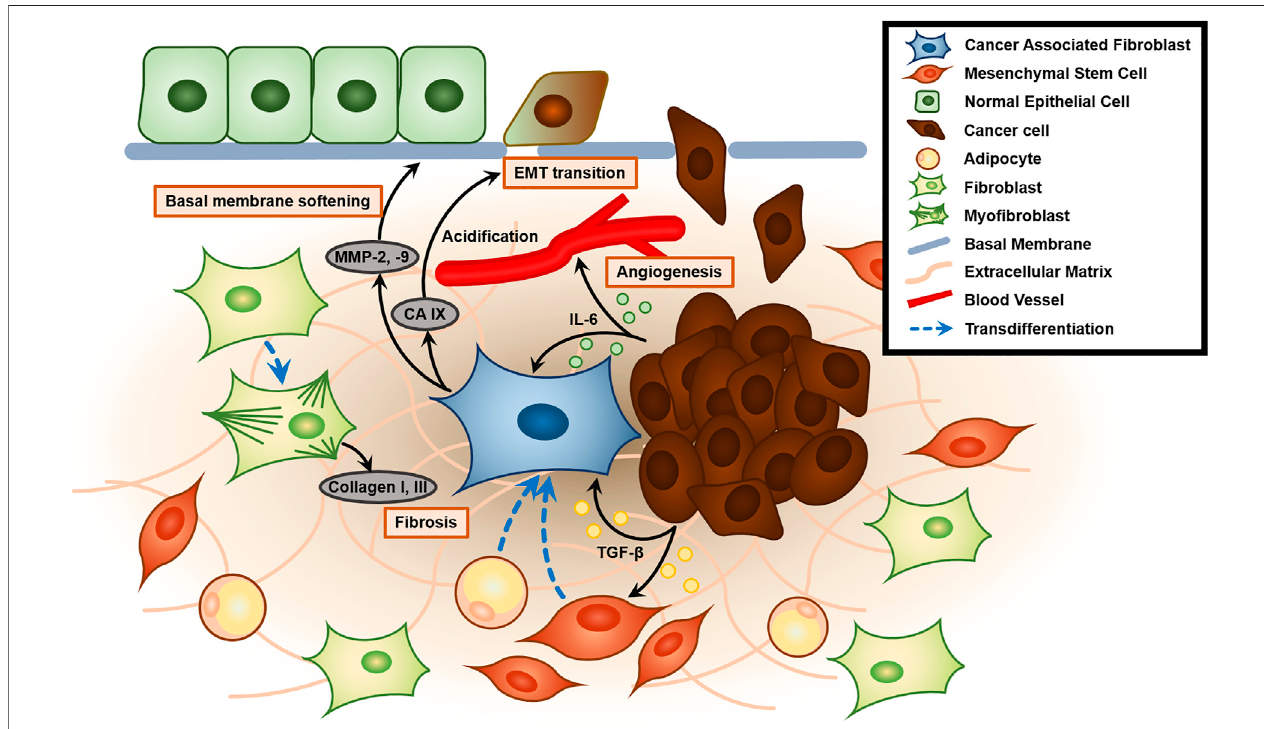
FIGURE 2 | Role of the cancer-associated fi broblast (CAF) and tumor microenvironment (TME) in enhancing tumor malignancy. Tumor-secreted TGF- β activates and recruits mesenchymal stem cells and induces transdifferentiation into CAFs. Activated CAFs generate MMP-2 and MMP-9, which mechanically contract and remodel ECM to soften the basal membrane. Furthermore, CAF also secretes CA IX, which causes acidi fi cation of ECM and promotes epithelial-to-mesenchymal transition (EMT transition). Tumors also secrete IL-6, which plays a key role in angiogenesis. Contractile protein α -SMA in CAF promotes transdifferentiation of fi broblasts to myo fi broblasts that excessively secrete collagen type 1 and 3, leading to fi brosis of the TME.